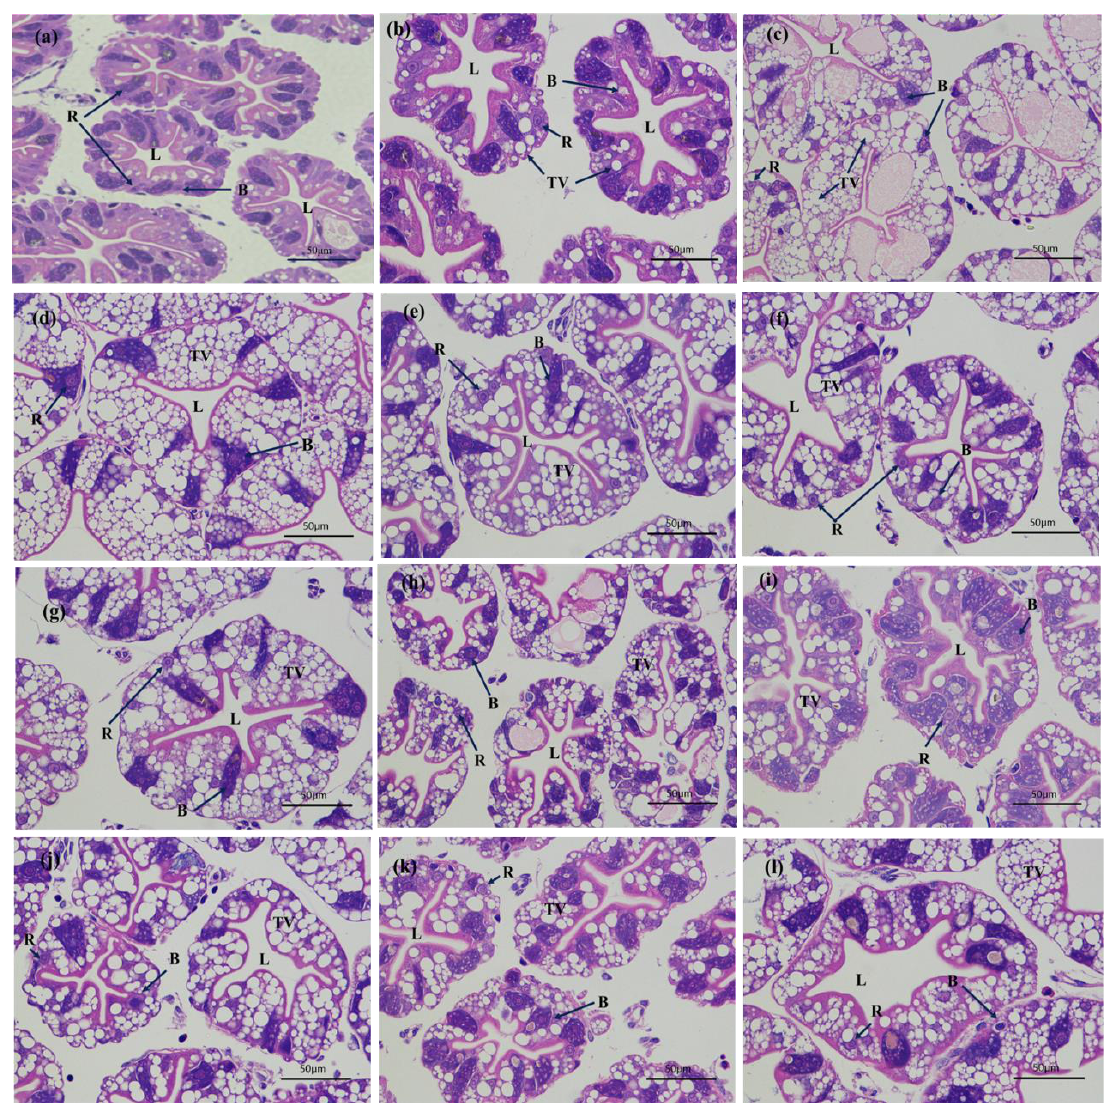
Figure 1. Effect of air exposure on hepatopancreas microstructure of P. clarkia. Notably, ( a – g ) show air exposure of 0 h, 1 h, 3 h, 6 h, 9 h, 12 h, and 24 h, respectively. Moreover, ( h – l ) shows re-submersion of 1 h, 3 h, 6 h, 12 h, and 24 h, respectively. B. B cell; R. R cell; L. Lumen; TV. Transferred vacuoles.